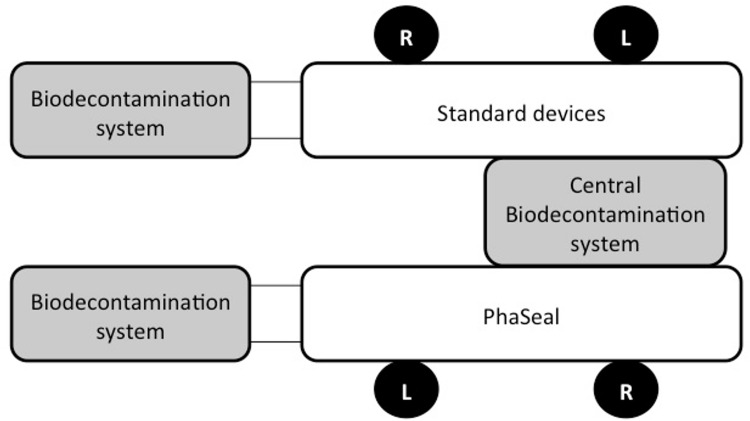
Scheme of the isolators and biodecontamination systems.The two isolators have two workstations each. In one isolator (Standard devices), the preparations are compounded only with spikes and needles. In the other isolator (Phaseal), the compounding process involves only Phaseal devices. Three biodecontamination systems are connected to the isolators. Sterilization is performed with hydrogen peroxide. The central biodecontamination system is an aeraulic barrier. There is no airflow between the two isolators.